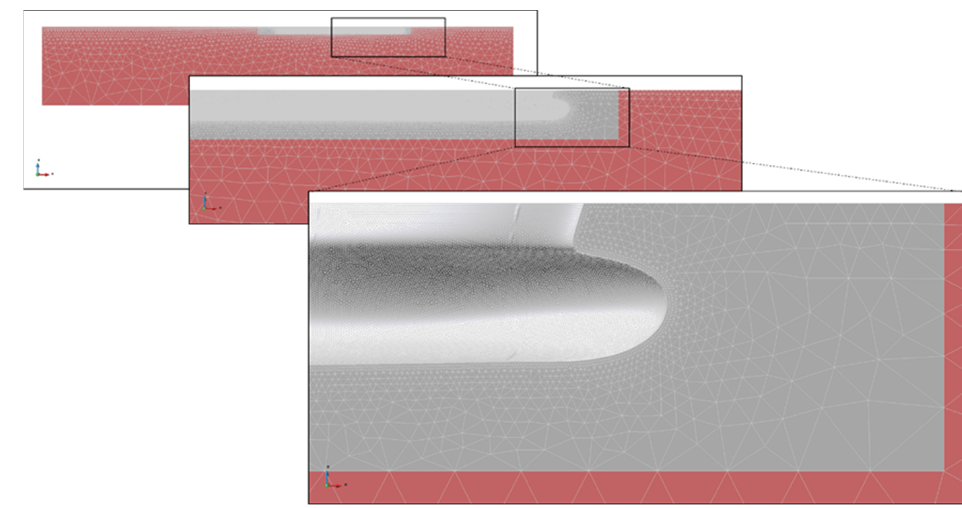
Figure 5. CFD details of mesh on bare hull resistance computations. Source: Own elaboration.